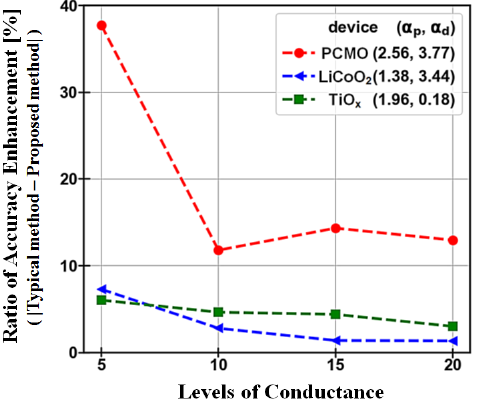
Figure 11. Ratio of accuracy enhancement between the proposed and typical method